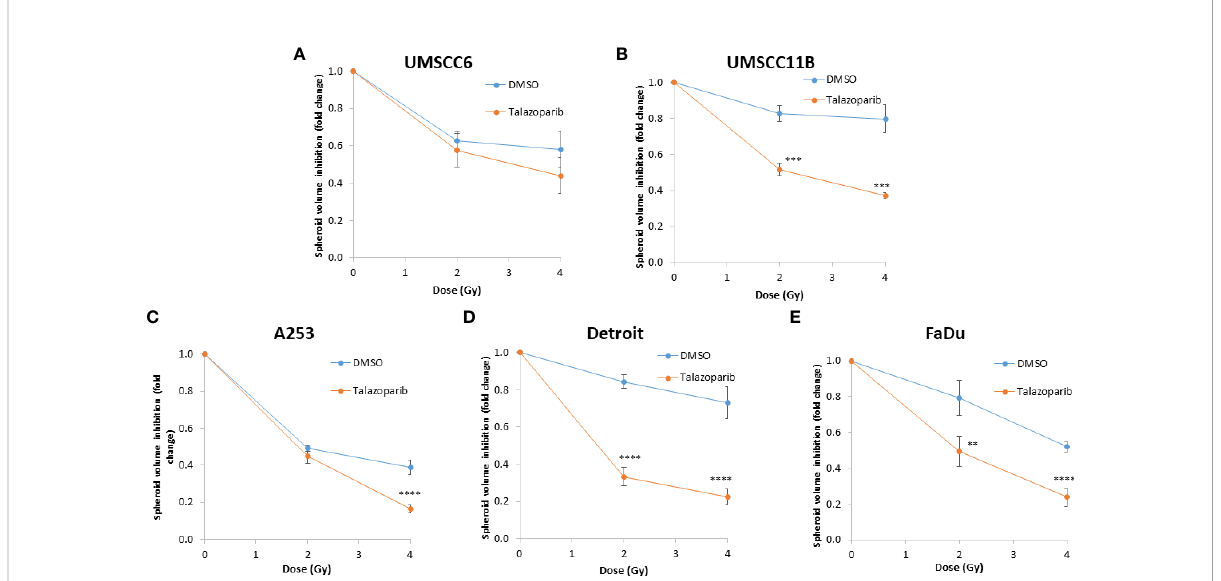
FIGURE 10 Impact of talazoparib on the enhancement of the radiosensitivity of HPV-negative HNSCC spheroids to protons. (A – E) The fold growth of HPV- negative HNSCC spheroids from days 3 to 11 post-seeding was determined relative to the proton dose, and this was normalised to the unirradiated control which was set to 1.0. **p < 0.02, ***p < 0.01, ****p < 0.001 as analysed by a two-sample